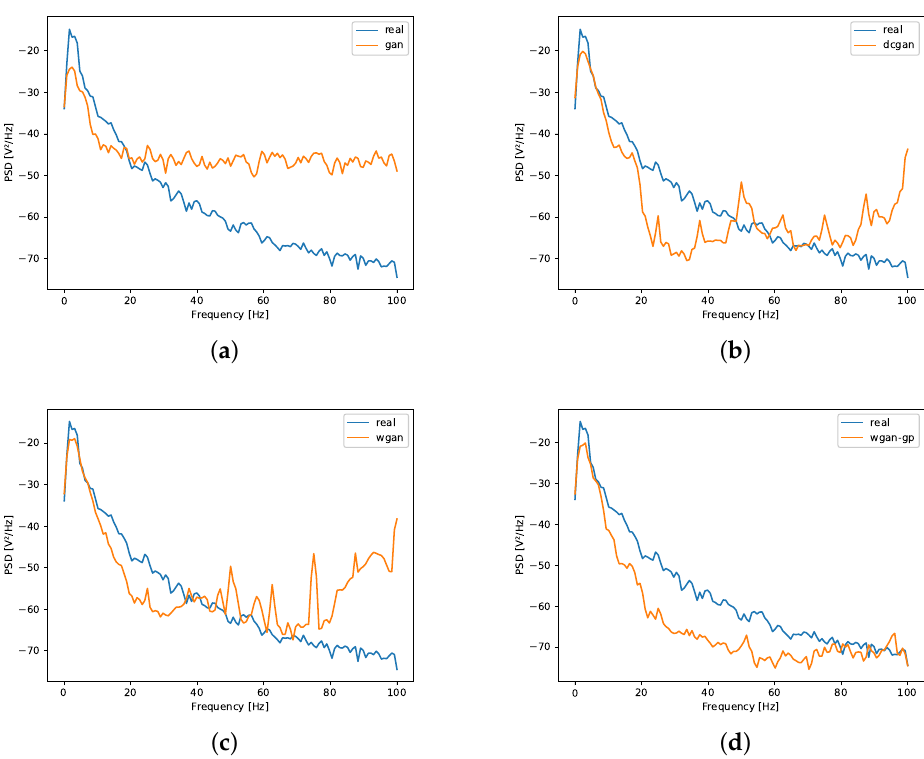
Figure 4. Comparison of the distribution of frequency spectra real signals and signals generated by different GAN architectures: ( a ) GAN; ( b ) DCGAN; ( c ) WGAN; ( d )